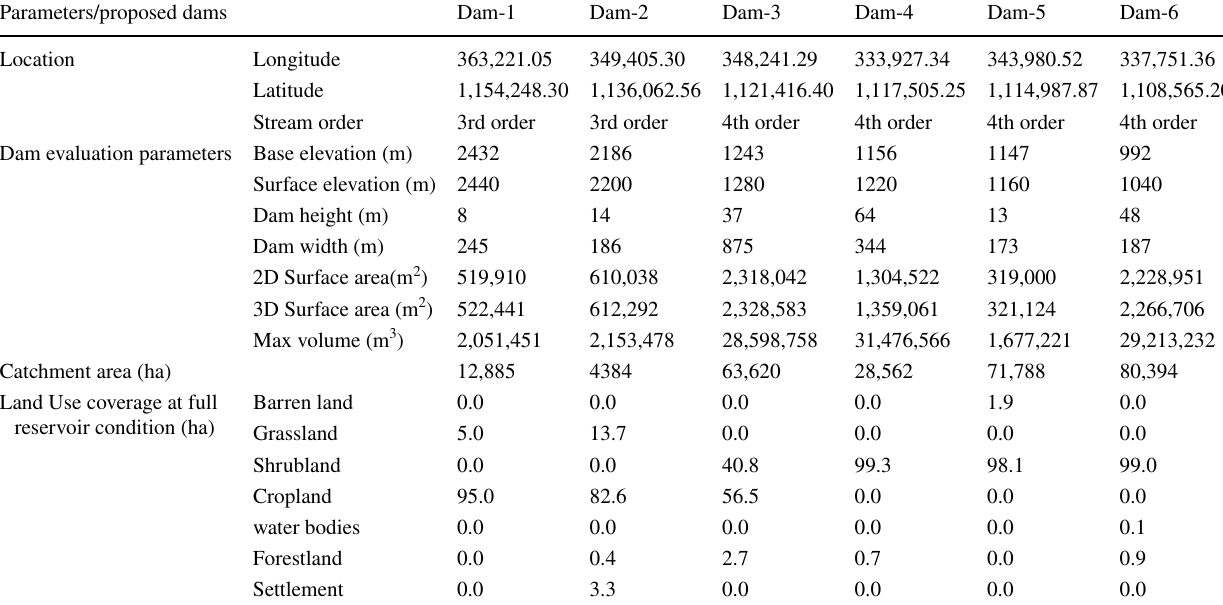
Table 13 Evaluation and essential parameters of the proposed dam sites